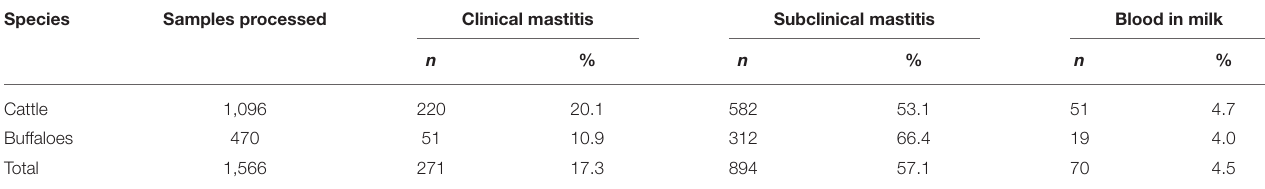
TABLE 1 | The prevalence of bovine mastitis in cattle and buffaloes. Species